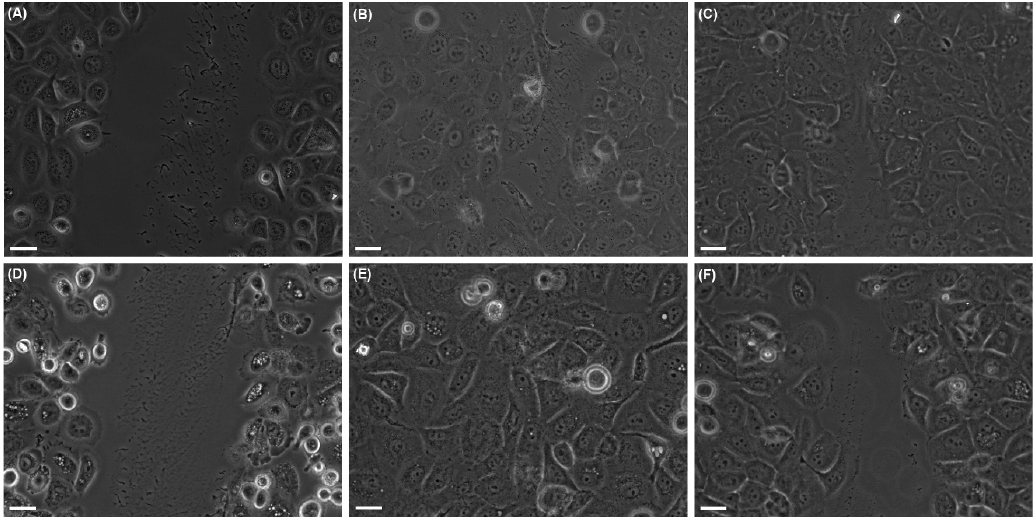
Figure 3. Effects of UVA irradiation on the ability of keratinocytes to cover the scratched area, in wound-healing experiments. ( A – C )—HaCaT; ( D – F )—DOK. ( A , D ) Mock-irradiated cells right after scratching; ( B , E ) mock-irradiated cells at 6 h after scratching; ( C , F ) cells irradiated for 30 min, at 6 h after UVA exposure. Scale bars represent 25 µm.